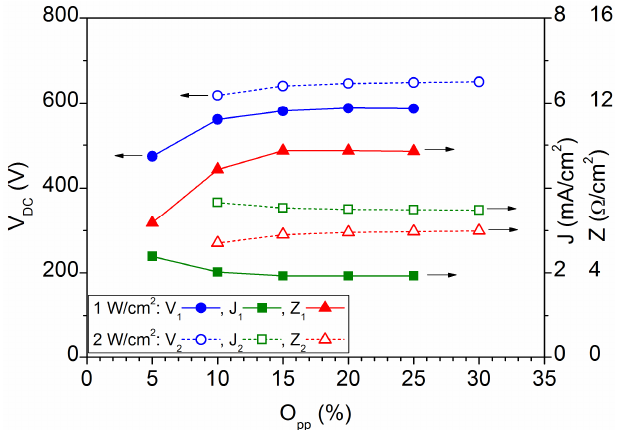
Figure 1. Discharge characteristics as a function of oxygen percentage for the two power values applied to the sputtering target.